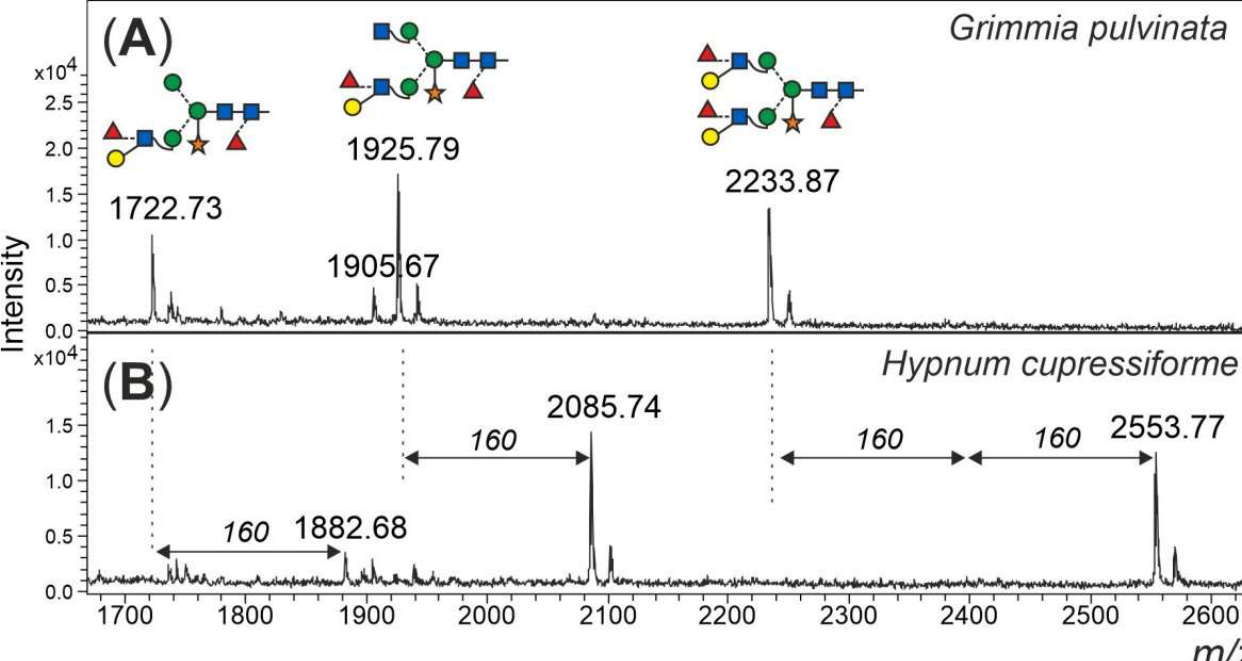
Figure 6. Large, unusual N-glycans occurring in some mosses. Panel ( A ) gives the high mass region of the moss Grimmia pulvinata with regular complex-type plant N-glycans. Panel ( B ) depicts the high mass region of the N-glycan pattern observed in a few moss species such as Hypnum curessiforme .